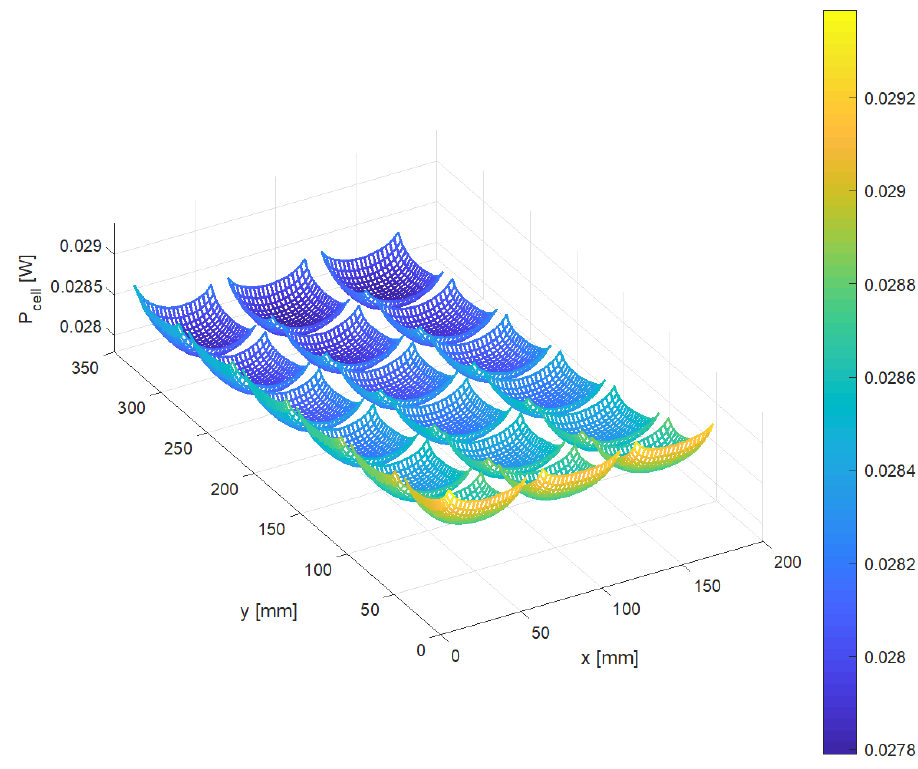
Figure 14. Produced power per cell.